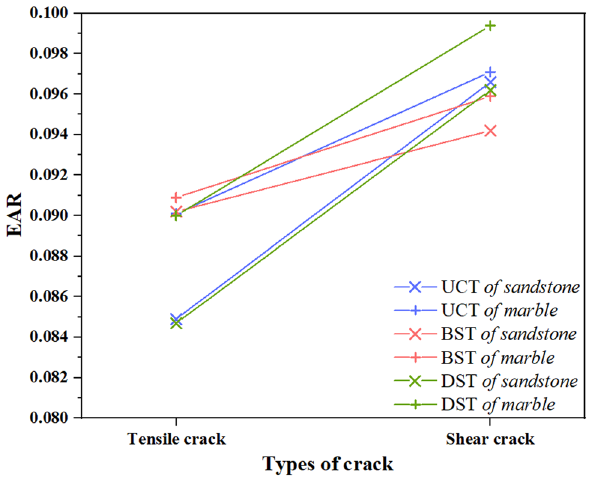
Fig. 10 Calculation results for energy–amplitude ratio